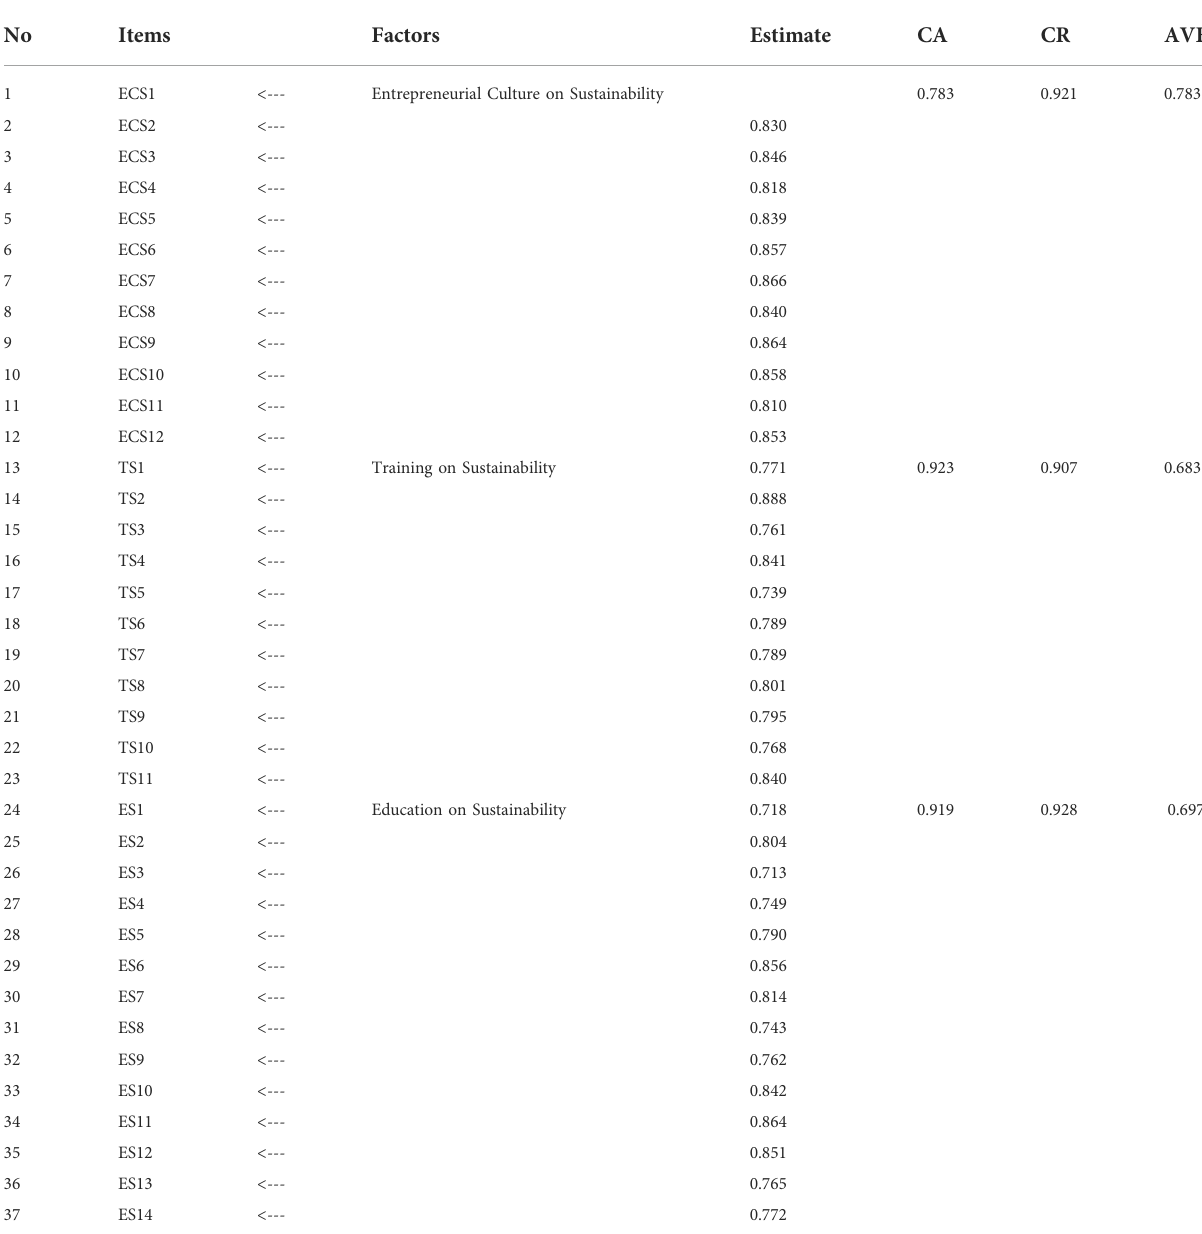
TABLE 1 Measurement model